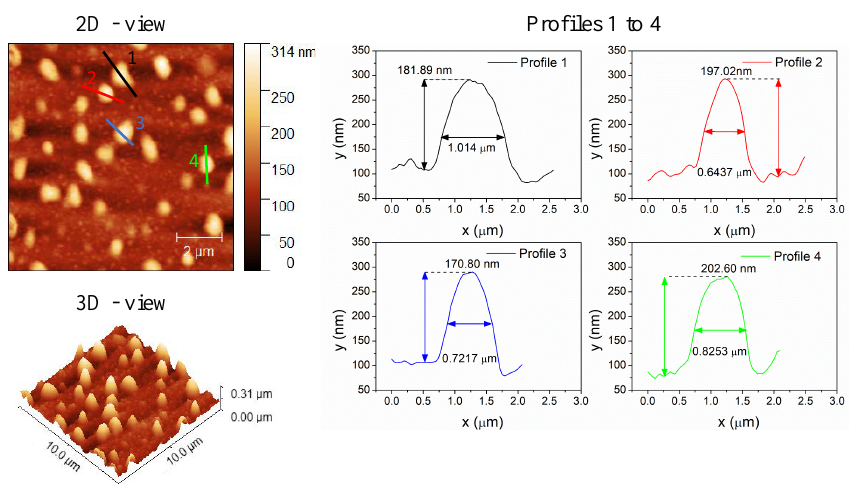
Figure 5. AFM topographic 2D and 3D images of LN2 nitrogen implanted die steel sample with the nominal fluence 1.0 × 10 18 at/cm 2 , with detailed profiles of four precipitates.